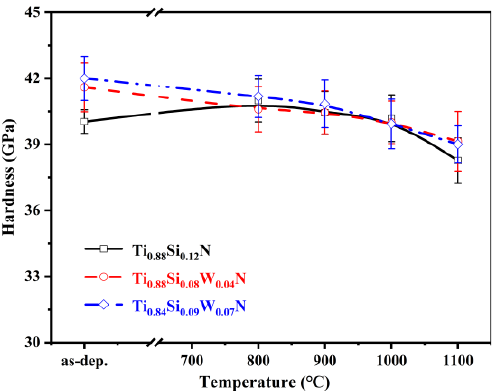
Figure 6. Hardness of Ti 0.88 Si 0.12 N, Ti 0.88 Si 0.08 W 0.04 N, and Ti 0.84 Si 0.09 W 0.07 N coatings as a function of annealing temperature.